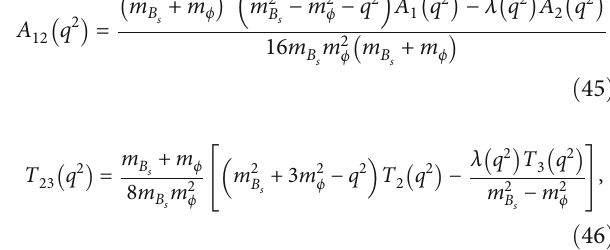
ð 0 Þ with the theoretical uncertainties from the variations of the parameters B s ⟶ ϕ